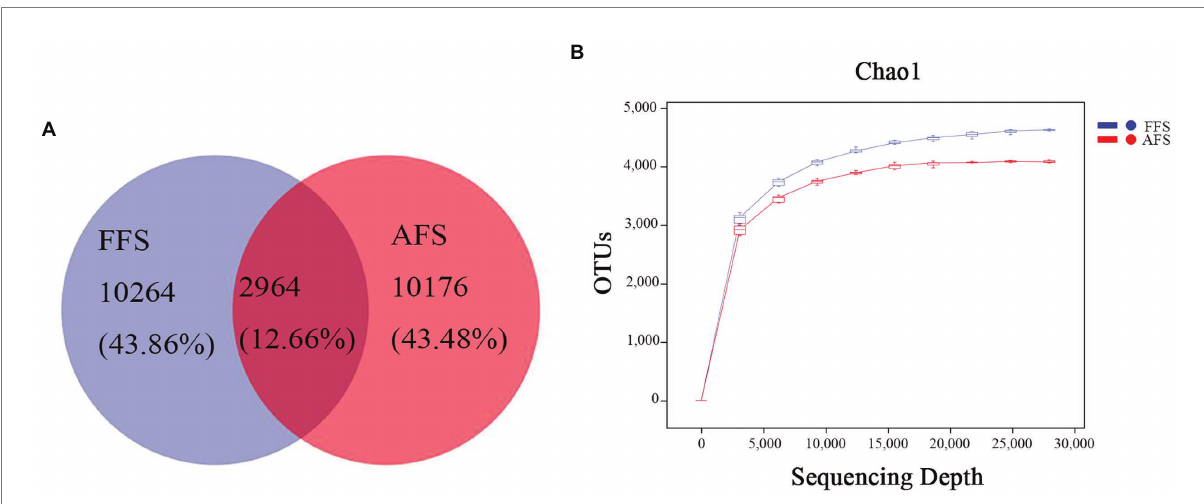
FIGURE 1 Venn diagrams (A) and the sparse curve (B) in bacterial communities in the selective-farming farmlands (FFS) and the abandoned farmlands (AFS). Different colored shapes represent different